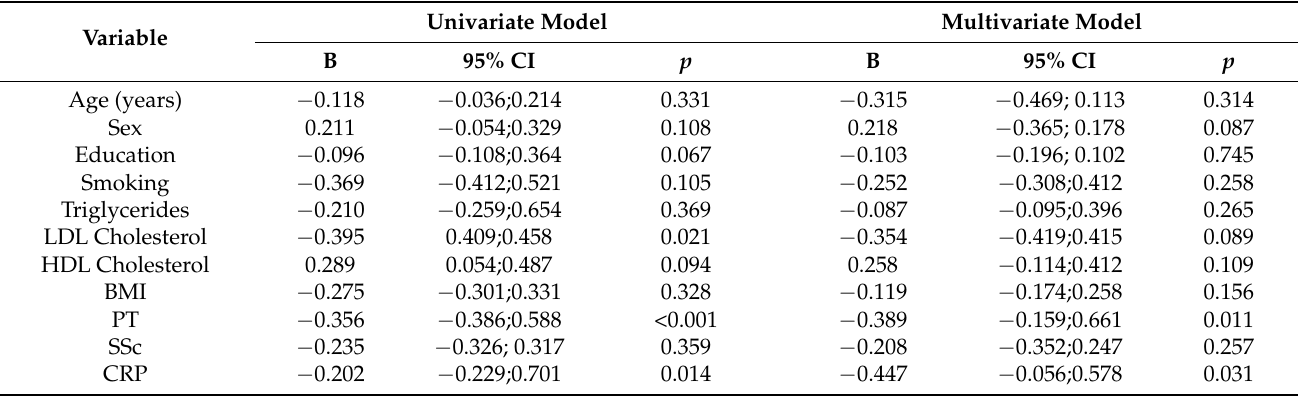
Table 4. Uni- and multivariate linear regression analysis. Age was included as a continuous variable. For PT, controls served as reference. For gender, male served as